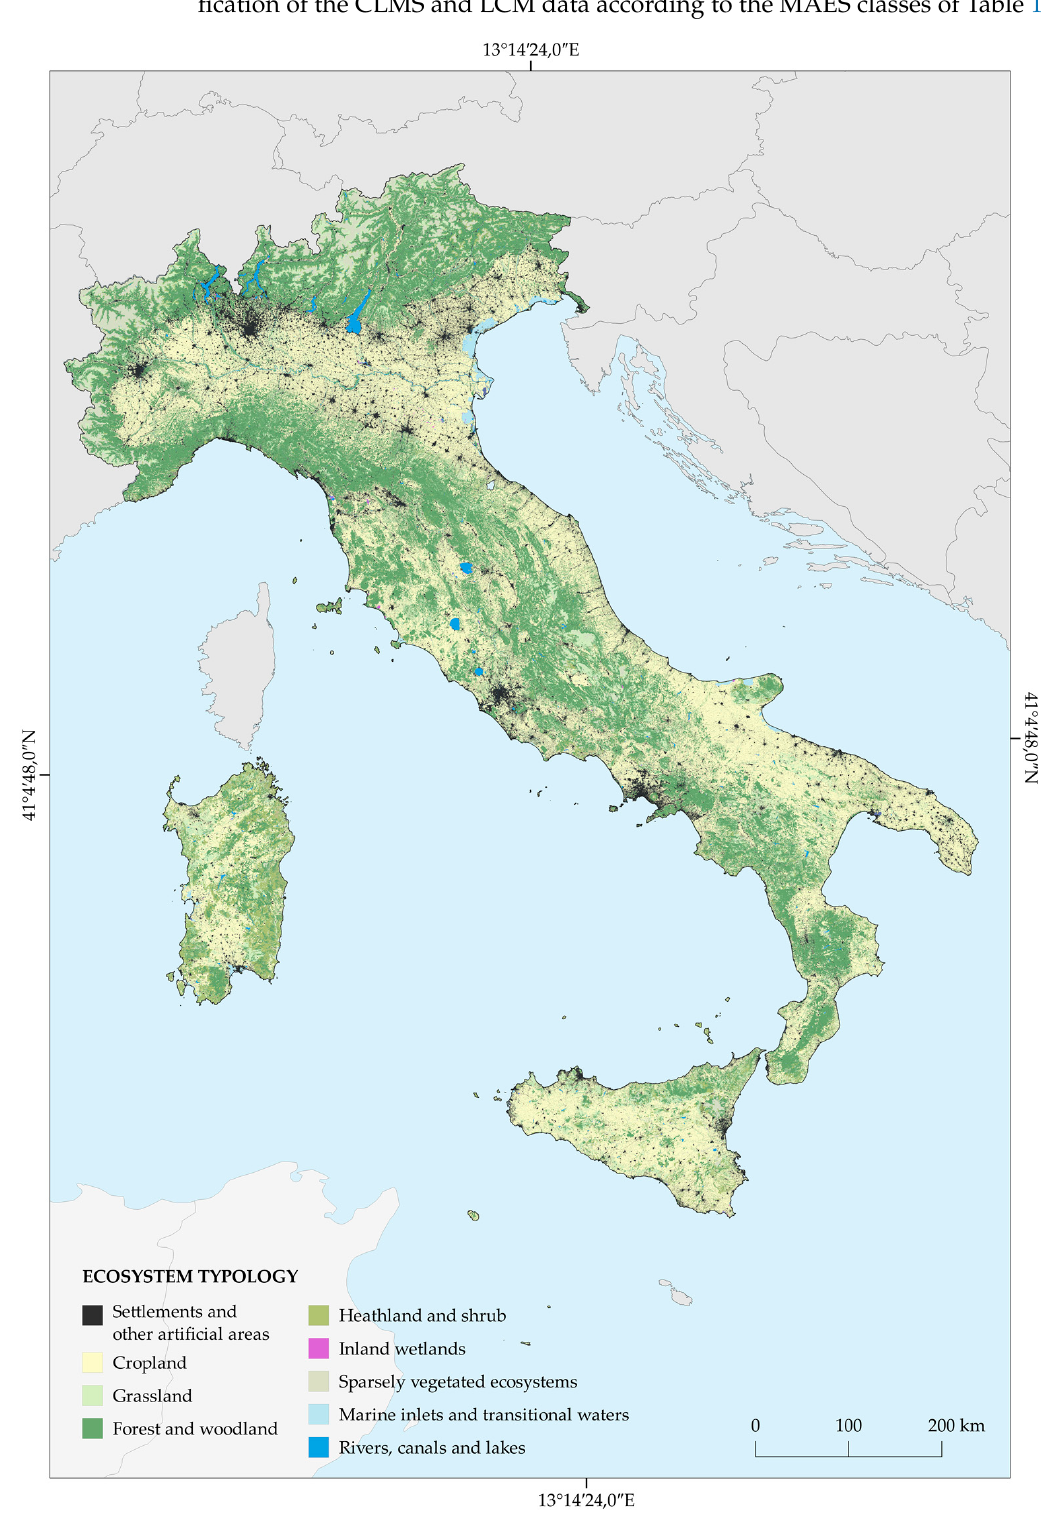
Figure 2. Ecosystem type map with MAES compliant classification system (2018).